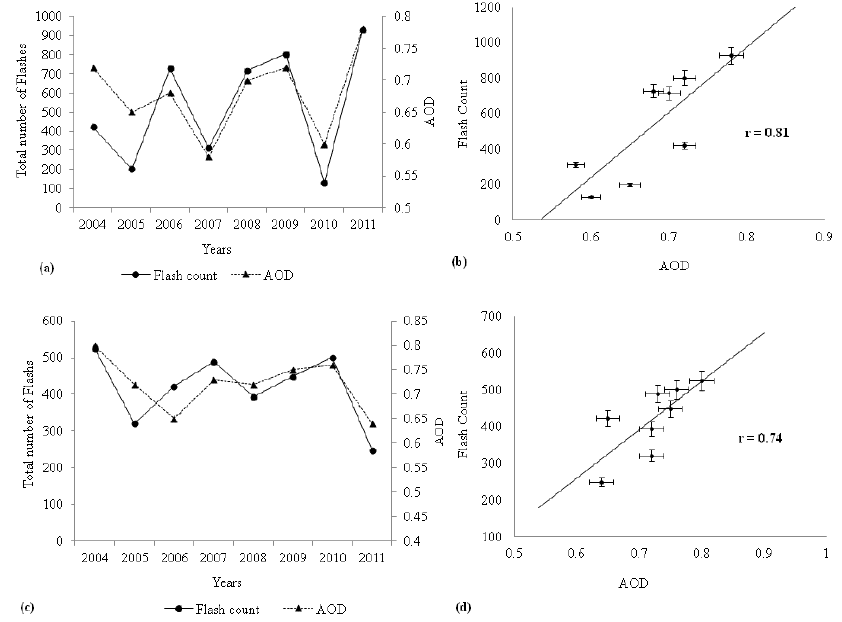
Figure 4. Comparison of flash count with AOD. ( a ) Variation in total number of flashes along with AOD over the years (2004–2011) and ( b ) their scatter plot during pre-monsoon months; ( c ) Monsoon period variation in total flashes and AOD and ( d ) their scatter plot. Crosshairs represent first standard deviation of the